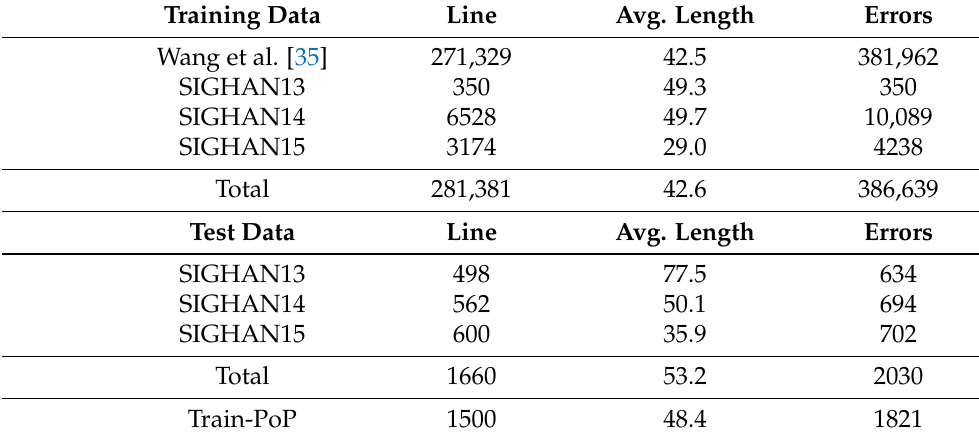
Table 2. Statistics information of the used data resources. Train-PoP is the data used to train the classifier. It comes from the original three SIGHAN test sets. We selected 500 sentences from each test set to form the training